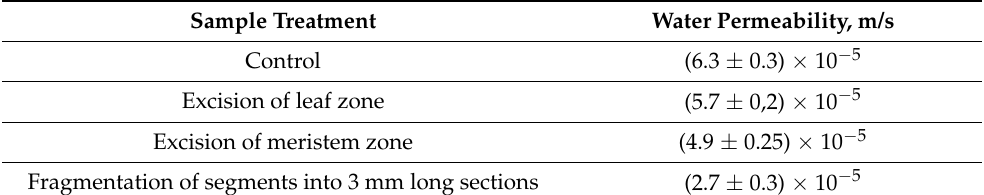
Table 1. Dynamics of a decrease in root values of effective permeability coefficients during sequential cutting off of the leaf zone, meristem, and fragmentation of the root suction zone [94].